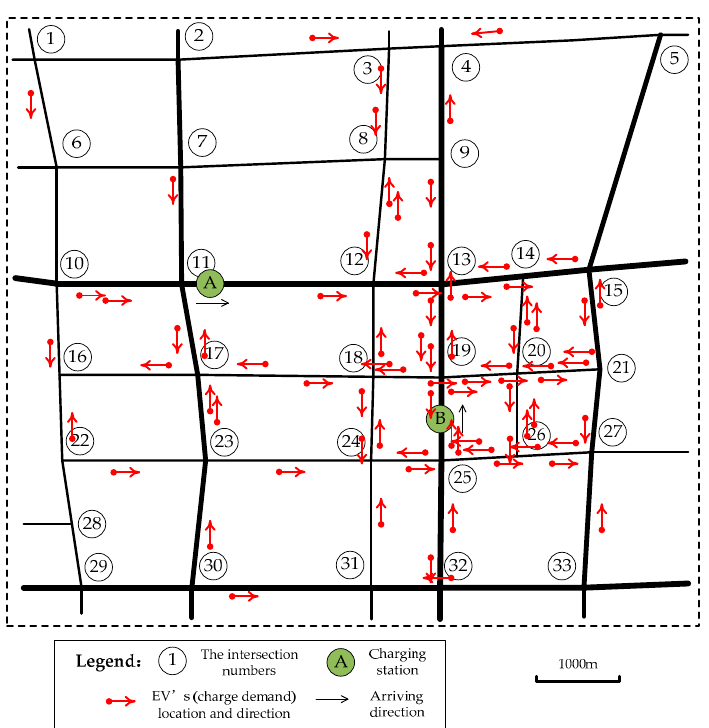
Figure 3. Sketch of the transportation network in the object region.